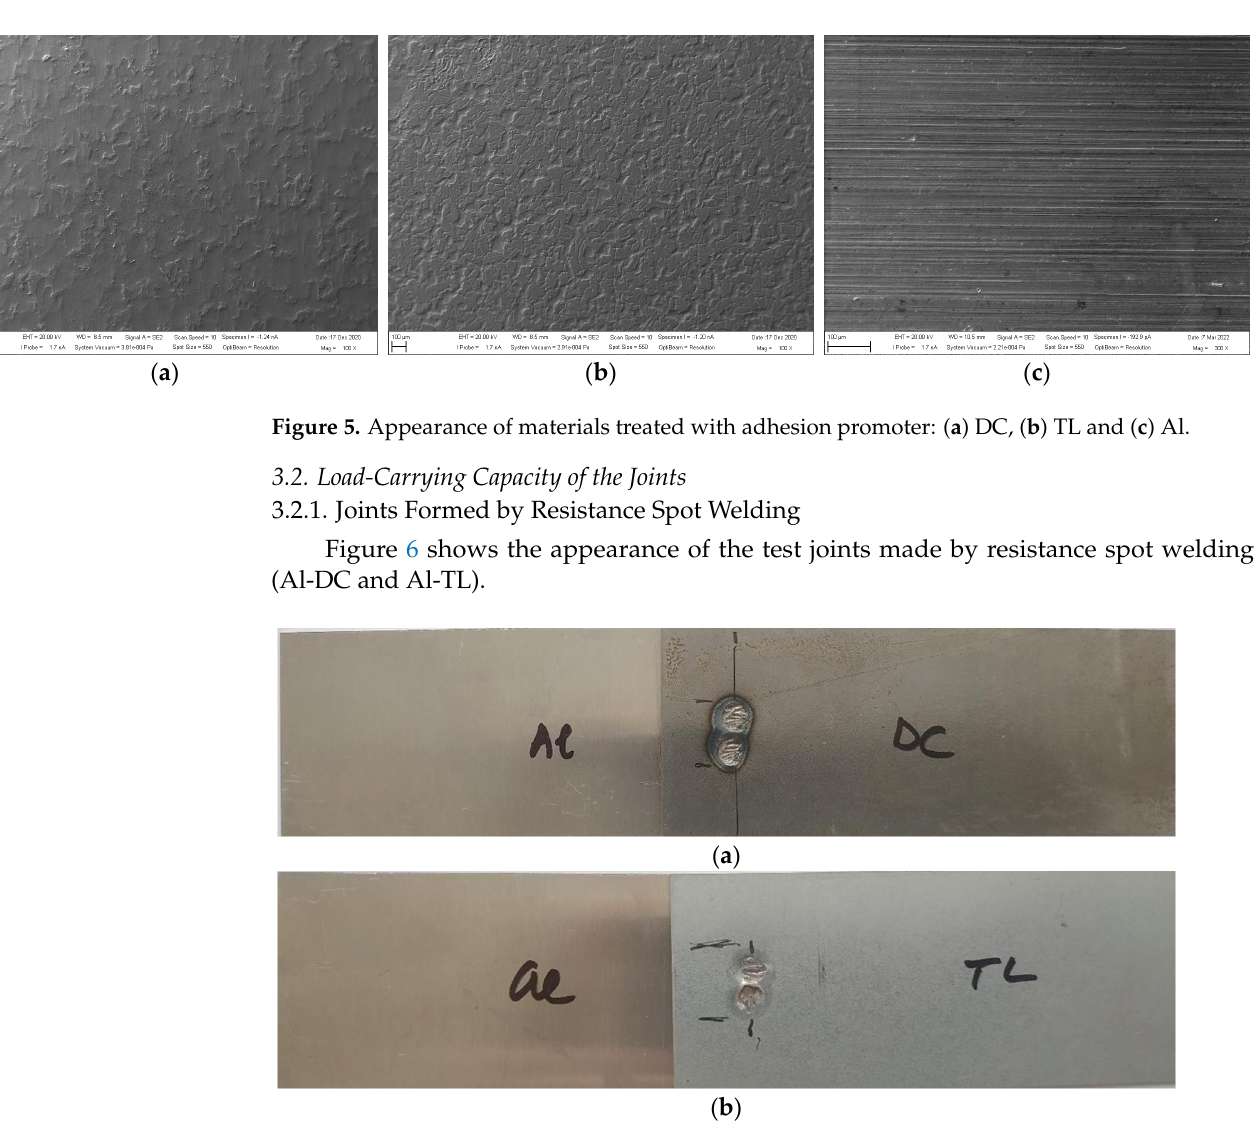
Figure 6. Appearance of test joints made by resistance spot welding: ( a ) Al-DC and ( b ) Al-TL.